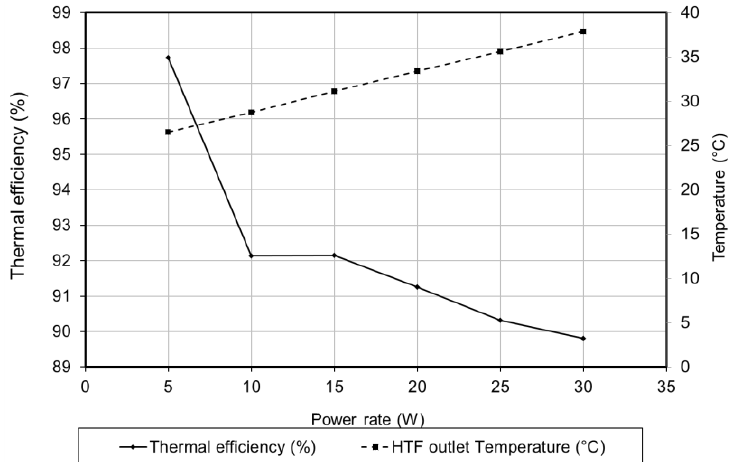
Figure 16. Effects of power rating on the HTF outlet temperature and thermal performance of three-layers MLM heat sink of 30 mL/min HTF flow rate.